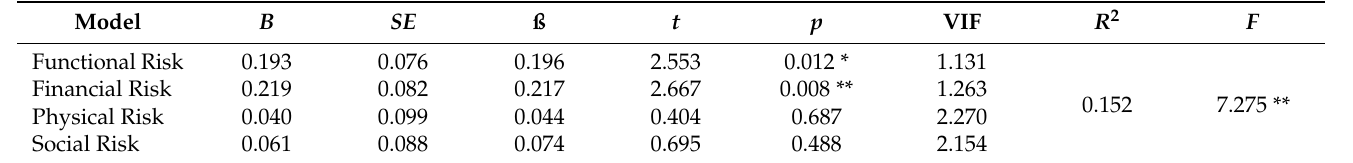
Table 7. Results of multiple regression using perceived risk to predict switching